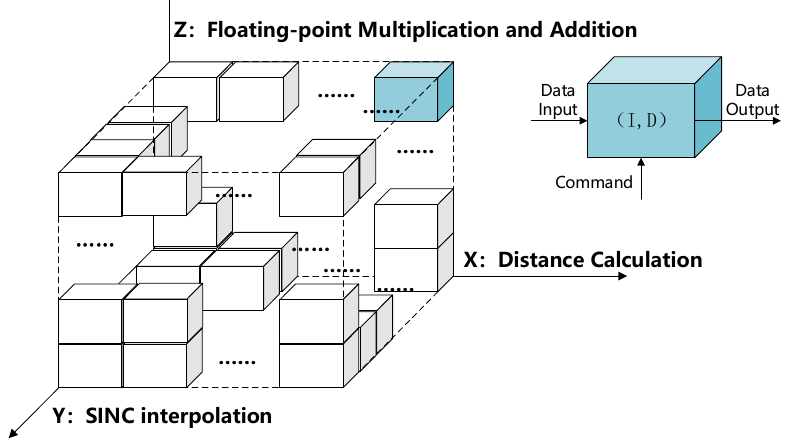
Figure 11. Schematic diagram explaining parallel data processing.